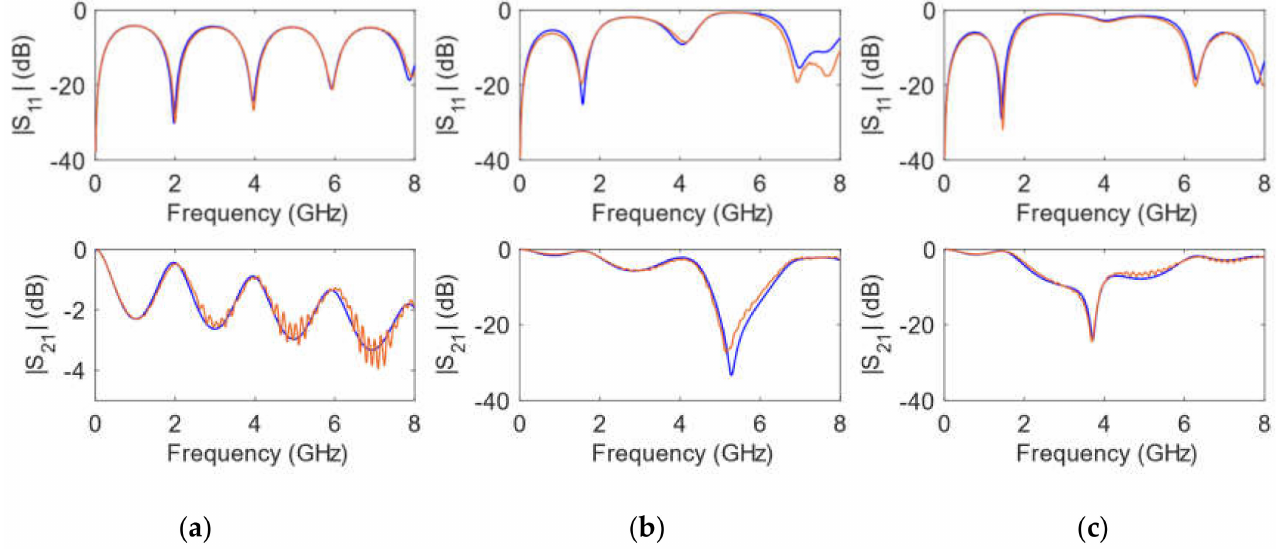
Figure 8. Simulated ( blue ) and measured ( orange ) calibrating elements magnitude of scattering parameters for a h = 1.6 mm substrate height. ( a ) transmission line; ( b ) short stub; ( c ) long stub.